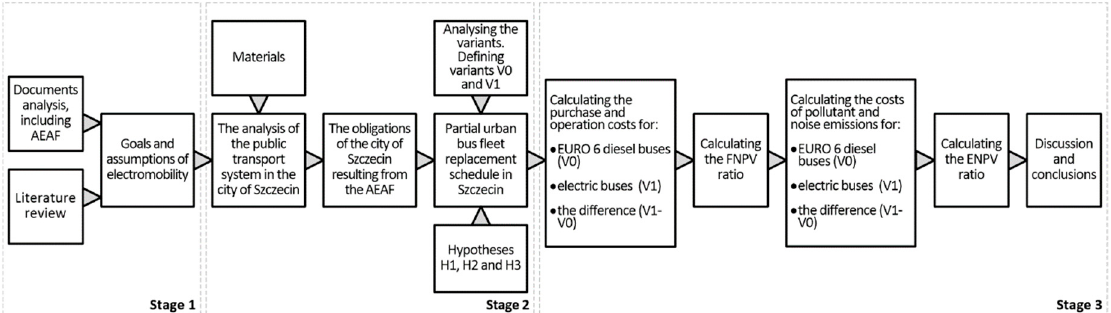
Figure 1. Stages of the research study.